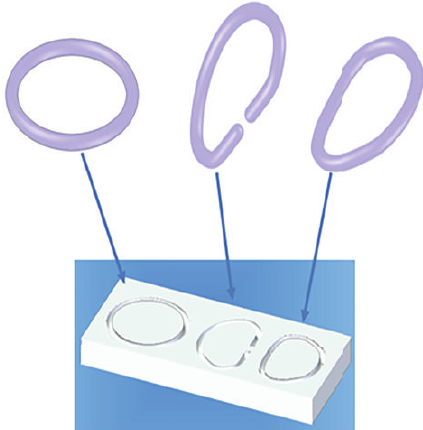
Figure1:Computer-aideddesignsofdifferentvalveringmodelsand associated mold